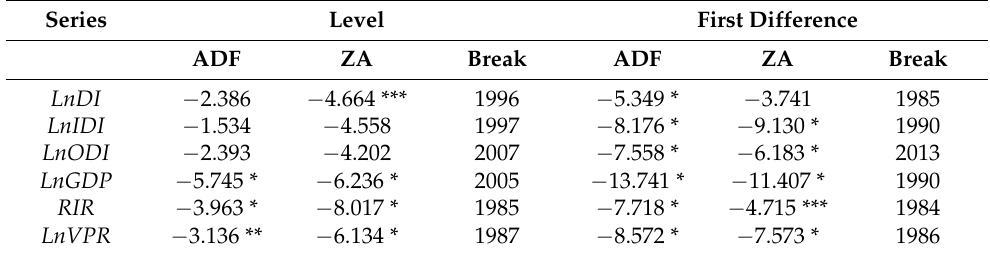
Table 3. Results of unit root tests.